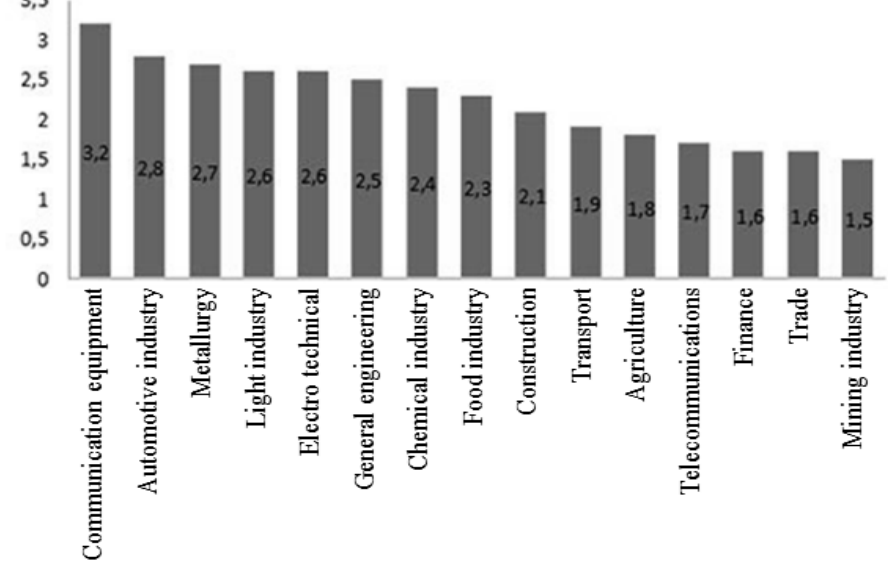
Fig. 1. The length of Global Value Chains by Industries (Kondratyev,